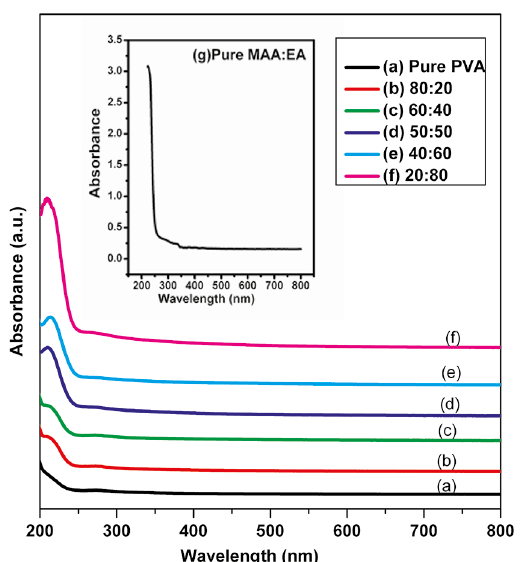
Figure 9. Absorption spectra of pure and blended PVA/MAA:EA samples (a) Pure PVA (b) 80:20 (c) 60:40 (d) 50:50 (e) 40:60 (f) 20:80 (g) Pure